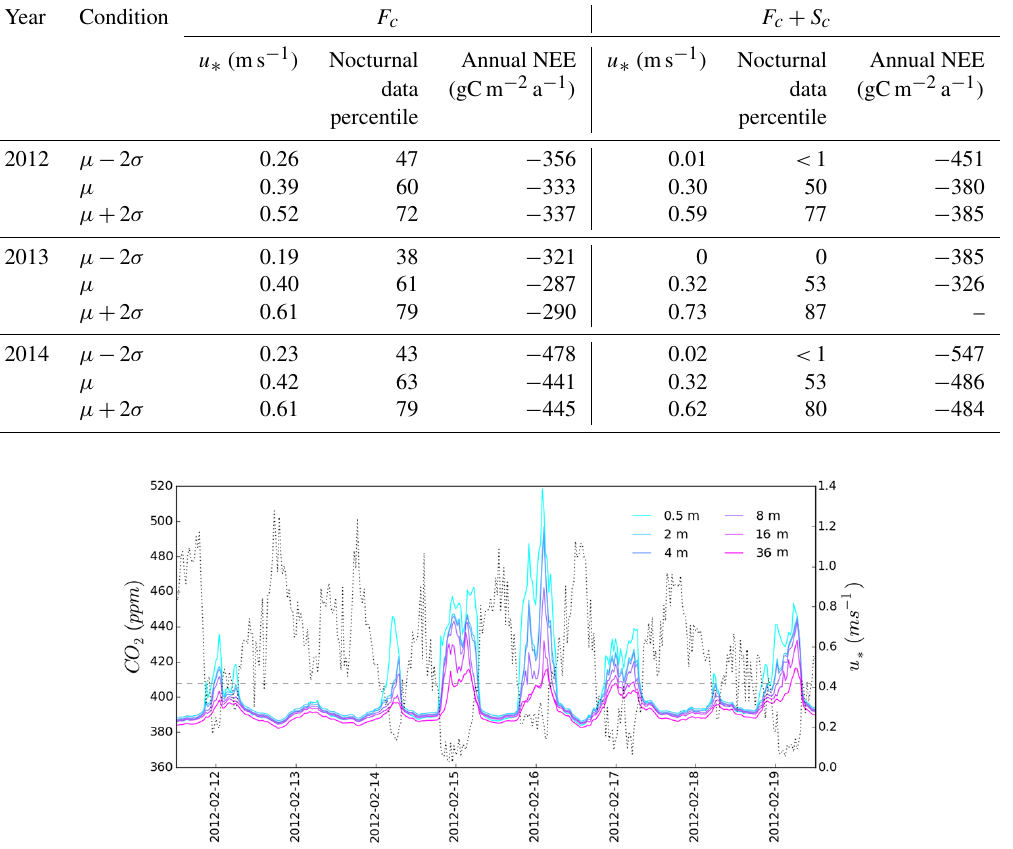
Table 4. Lower 95%CI bound ( µ − 2 σ) , mean ( µ) , and upper 95%CI bound ( µ + 2 σ) of Gaussian PDF of u ∗ th (derived from change-point detection of bootstrapped samples; see Methods), data percentile (i.e. percentage data excluded for each u ∗ th ) and resulting imputed annual estimate of NEE. Note that (i) µ − 2 σ set to zero if < 0 (e.g. F c + S c in 2013), (ii) respiration and light-response function analysis could not find a solution for F c + S c in 2013 when u ∗ = 0 . 73 (insufficient data for robust statistical fit).